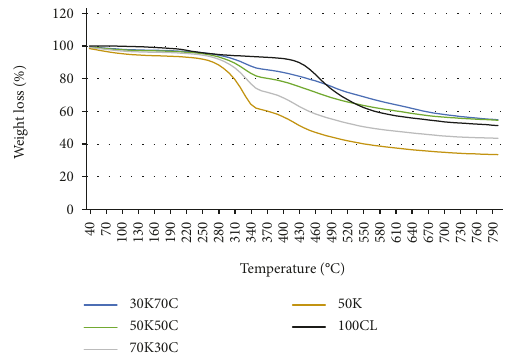
Figure 3: TGA of the hybrid